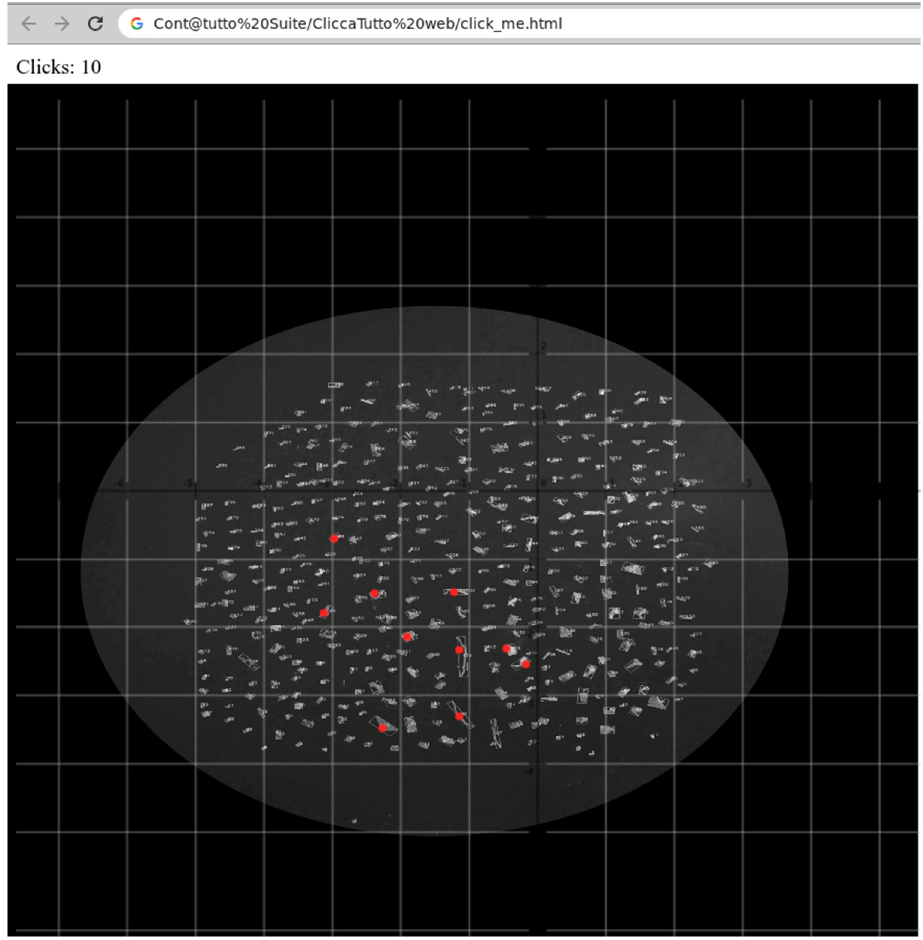
Figure 5. Details of graphical user interfaces used for manual counting.